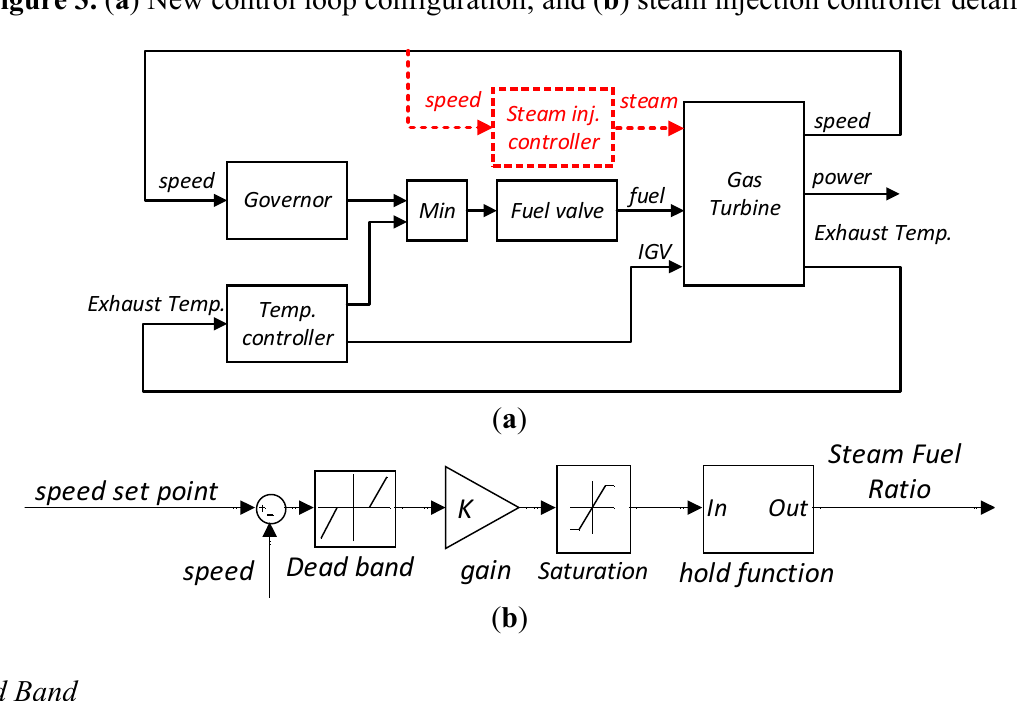
Figure 3. ( a ) New control loop configuration; and ( b ) steam injection controller